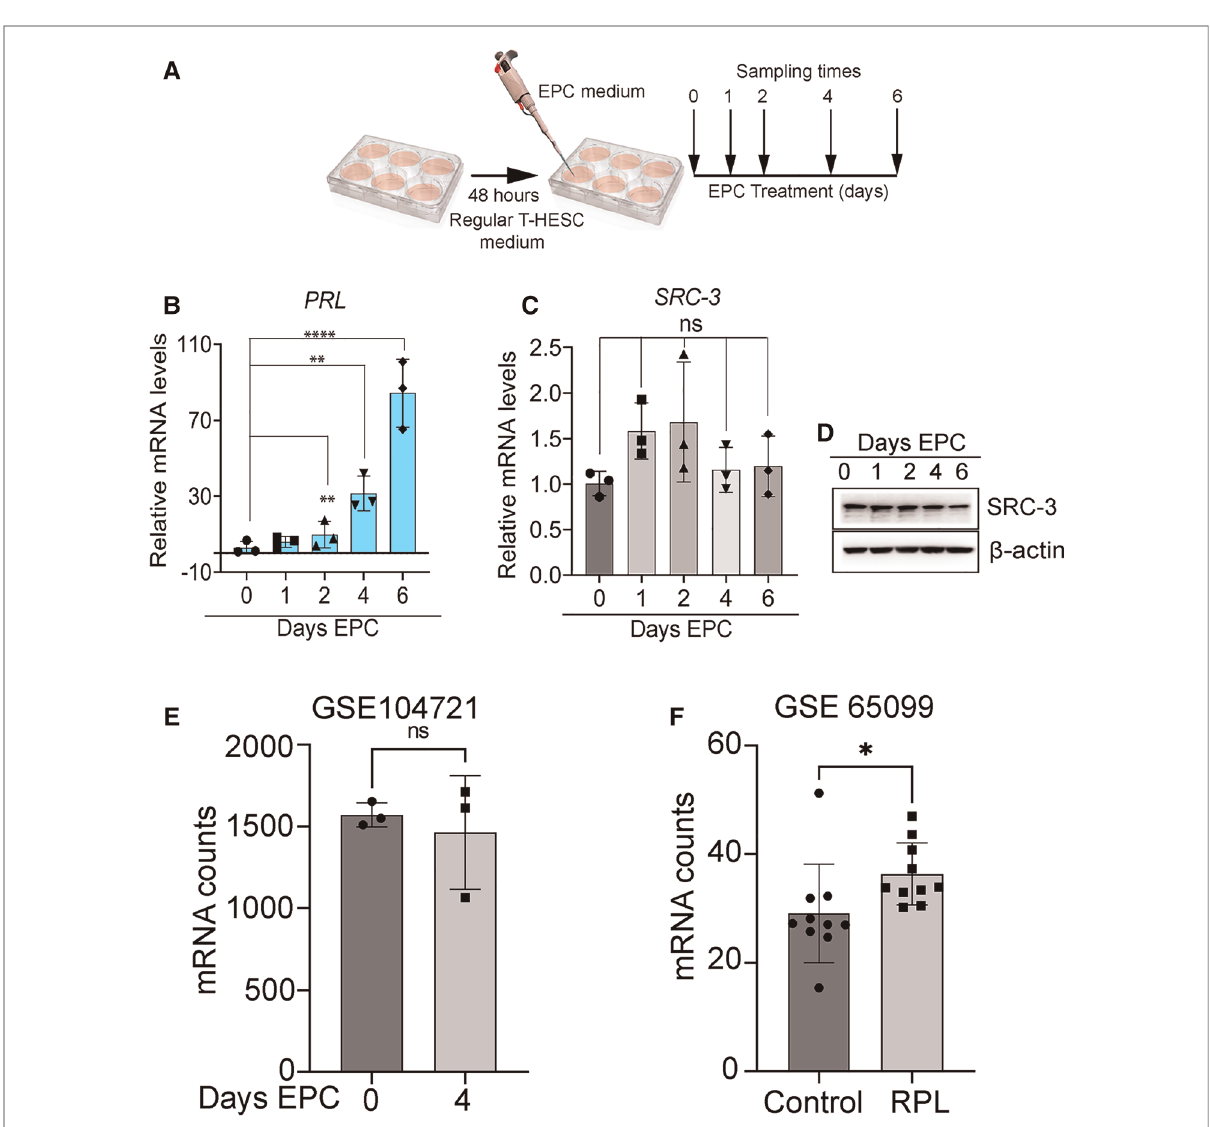
FIGURE 2 Expression levels of SRC-3 do not signi fi cantly change during T-HESC decidualization. ( A ) Schematic summarizes the experimental design of EPC decidualization of T-HESCs in culture. Following culture in standard culture medium for forty-eight hours, T-HESCs were switched to EPC medium to elicit decidualization over time. Cells were harvested at 0, 1, 2, 4, and 6 days following EPC administration for qPCR and western analysis. ( B ) As expected, the established PRL biomarker for decidualization (43) is signi fi cantly induced following EPC administration with